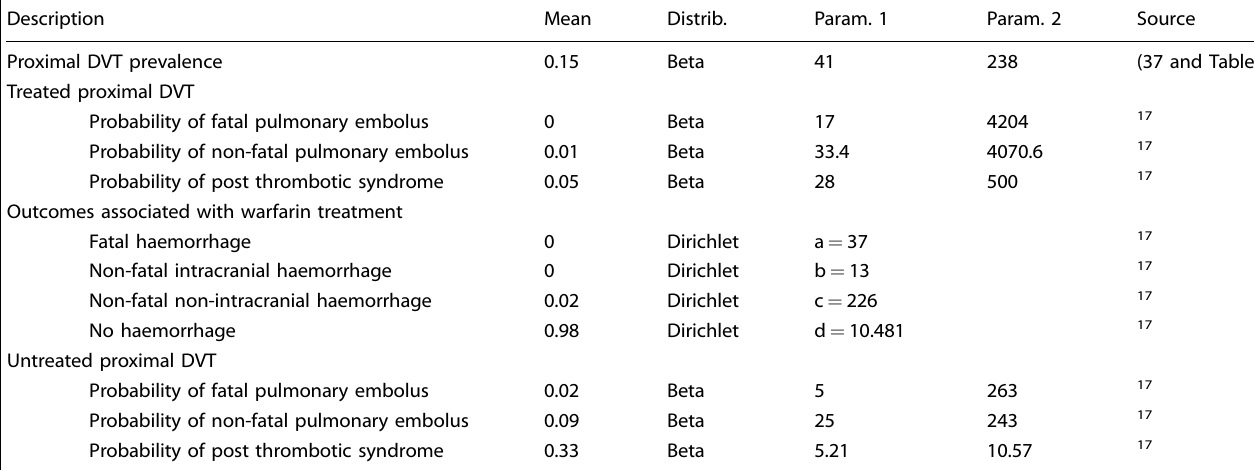
Table 12. Proximal DVT prevalence and outcomes associated with treated and untreated proximal DVT.